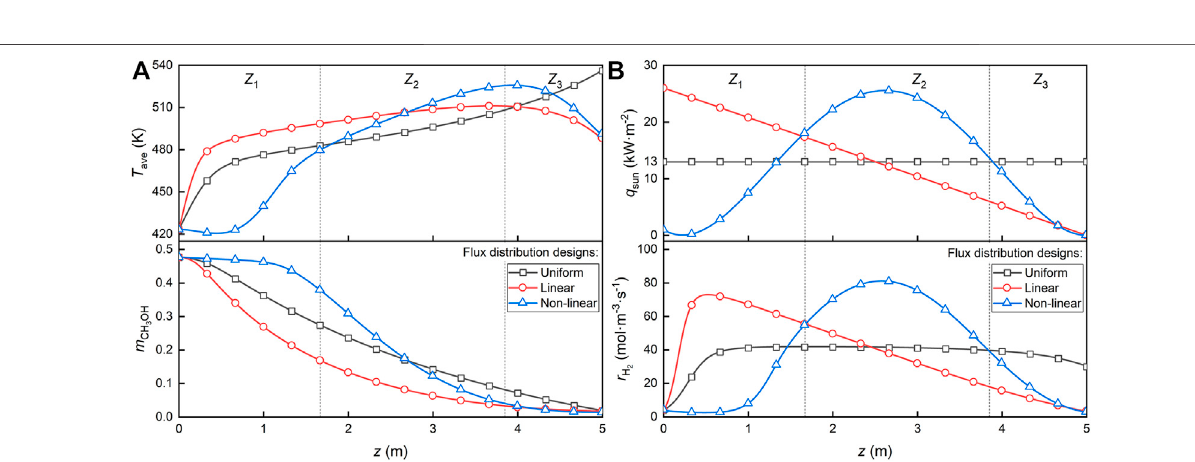
Frontiers in Energy Research |